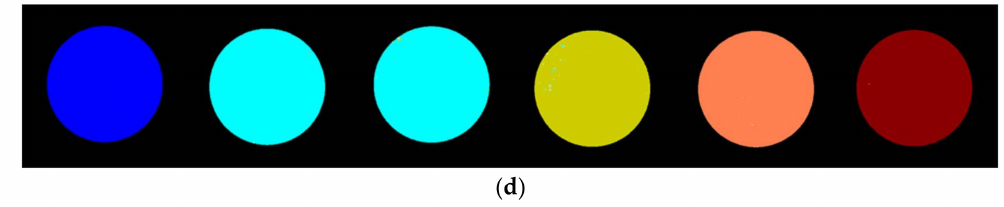
Figure 6. ( a ) PC 2 to PC 6 score plot of A. flavus ; ( b ) PC 2 to PC 6 score plot of A. parasiticus ; ( c ) classes projected onto image of A. flavus ; and ( d ) classes projected onto image of A. parasiticus .